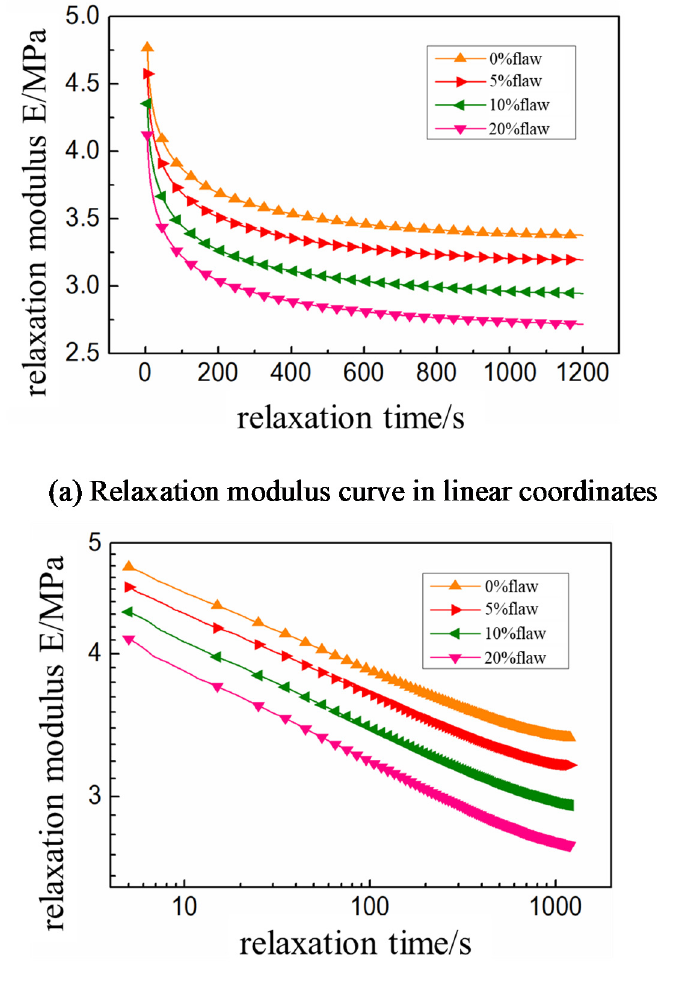
Figure 11. Stress relaxation results of HTPB propellant with initial interface defects.